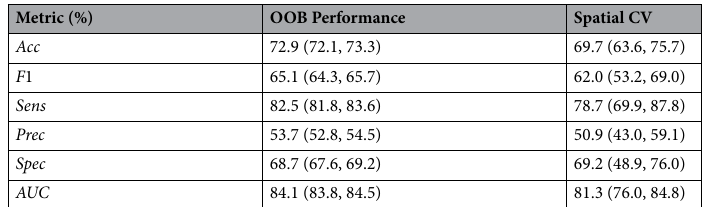
Table 1. The medians and 95% confidence intervals for all adopted metrics are reported and out-of-bag (OOB) performances of models with and without spatial cross-validation (CV) are compared. We evaluated our machine learning models in terms of accuracy ( Acc ), F 1 score, sensitivity ( Sens ), precision ( Prec ), specificity ( Spec ) and area under the ROC curve ( AUC